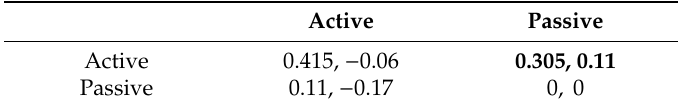
Table 7. Payo ff matrix A for 2 × 2 (Scrum Master vs. OTM) game for the least e ff ective team with